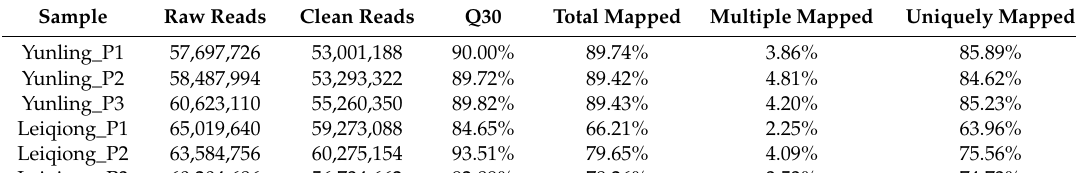
Table 1. Summary of reads mapping to the bovine transcriptomes.